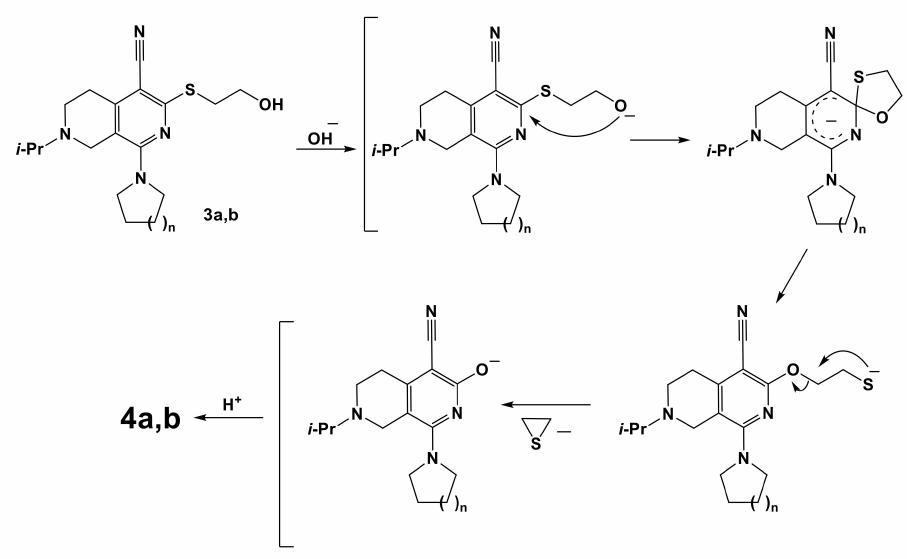
Scheme 2. Mechanism of the rearrangement proposed for the synthesis of compounds 4